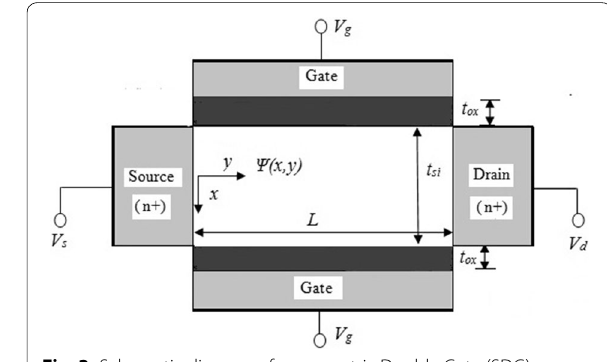
Fig. 3 Schematic diagram of a symmetric Double Gate (SDG)